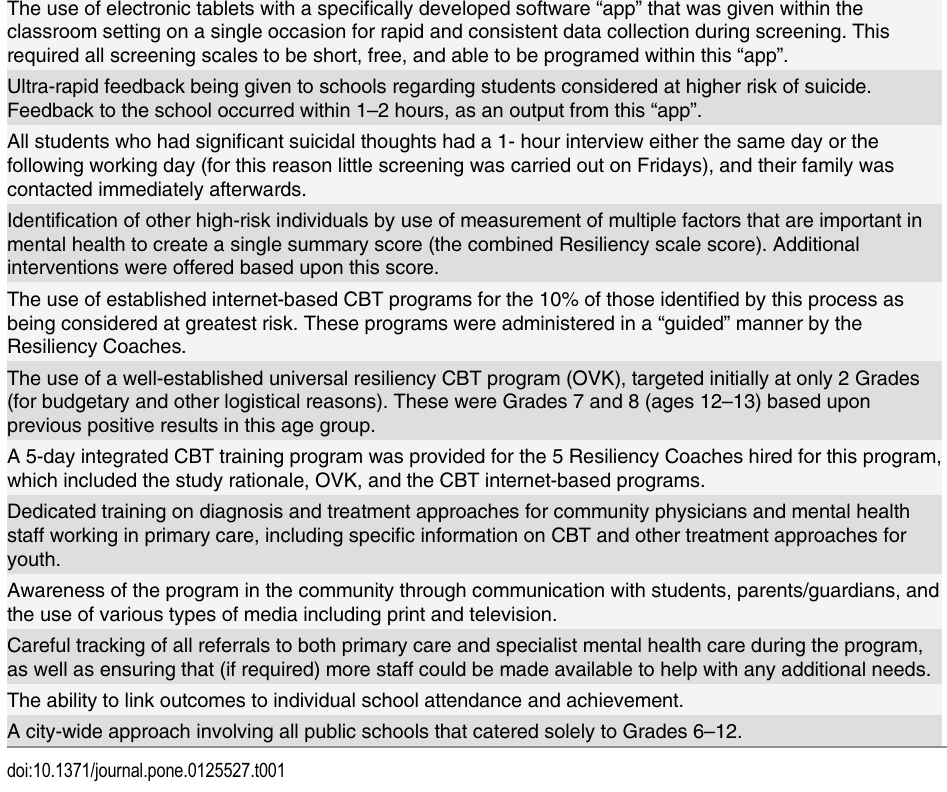
Table 1. Some of the novel multimodal approaches utilized in EMPATHY program. The use of electronic tablets with a speci fi cally developed software “ app ” that was given within the classroom setting on a single occasion for rapid and consistent data collection during screening. This required all screening scales to be short, free, and able to be programed within this “ app ” . Ultra-rapid feedback being given to schools regarding students considered at higher risk of suicide. Feedback to the school occurred within 1 – 2 hours, as an output from this “ app ”